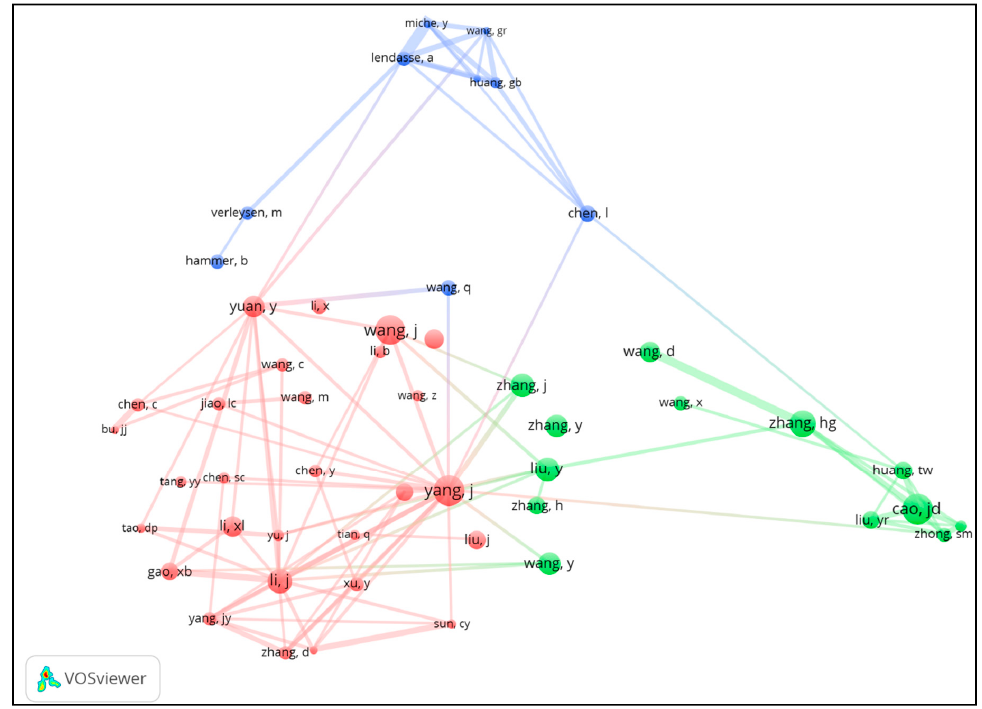
Figure 7. Bibliographic coupling of the authors in NC.